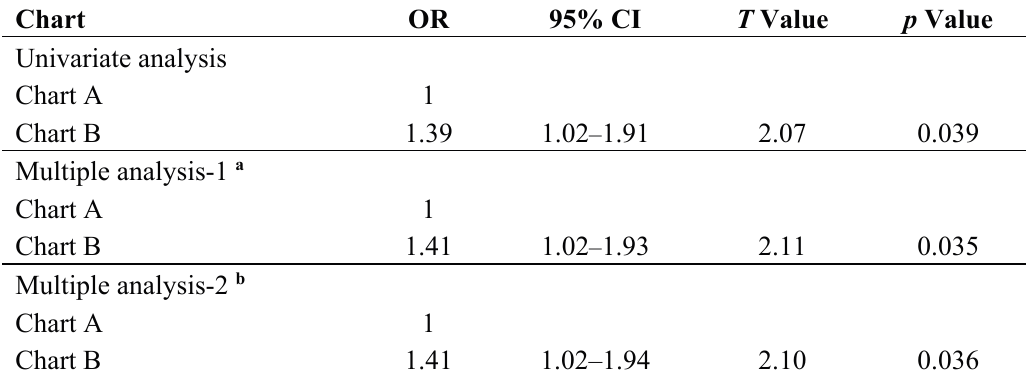
Table 4. Multivariable model of ‘full breastfeeding’ at 6 months by growth chart